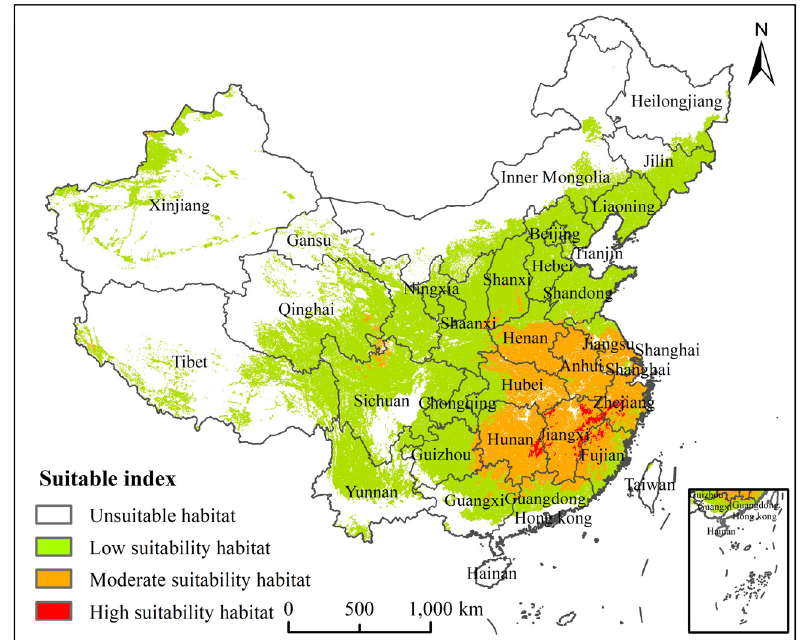
Figure 6. Potential suitable habitats for Helicoverpa zea in China under current climate.